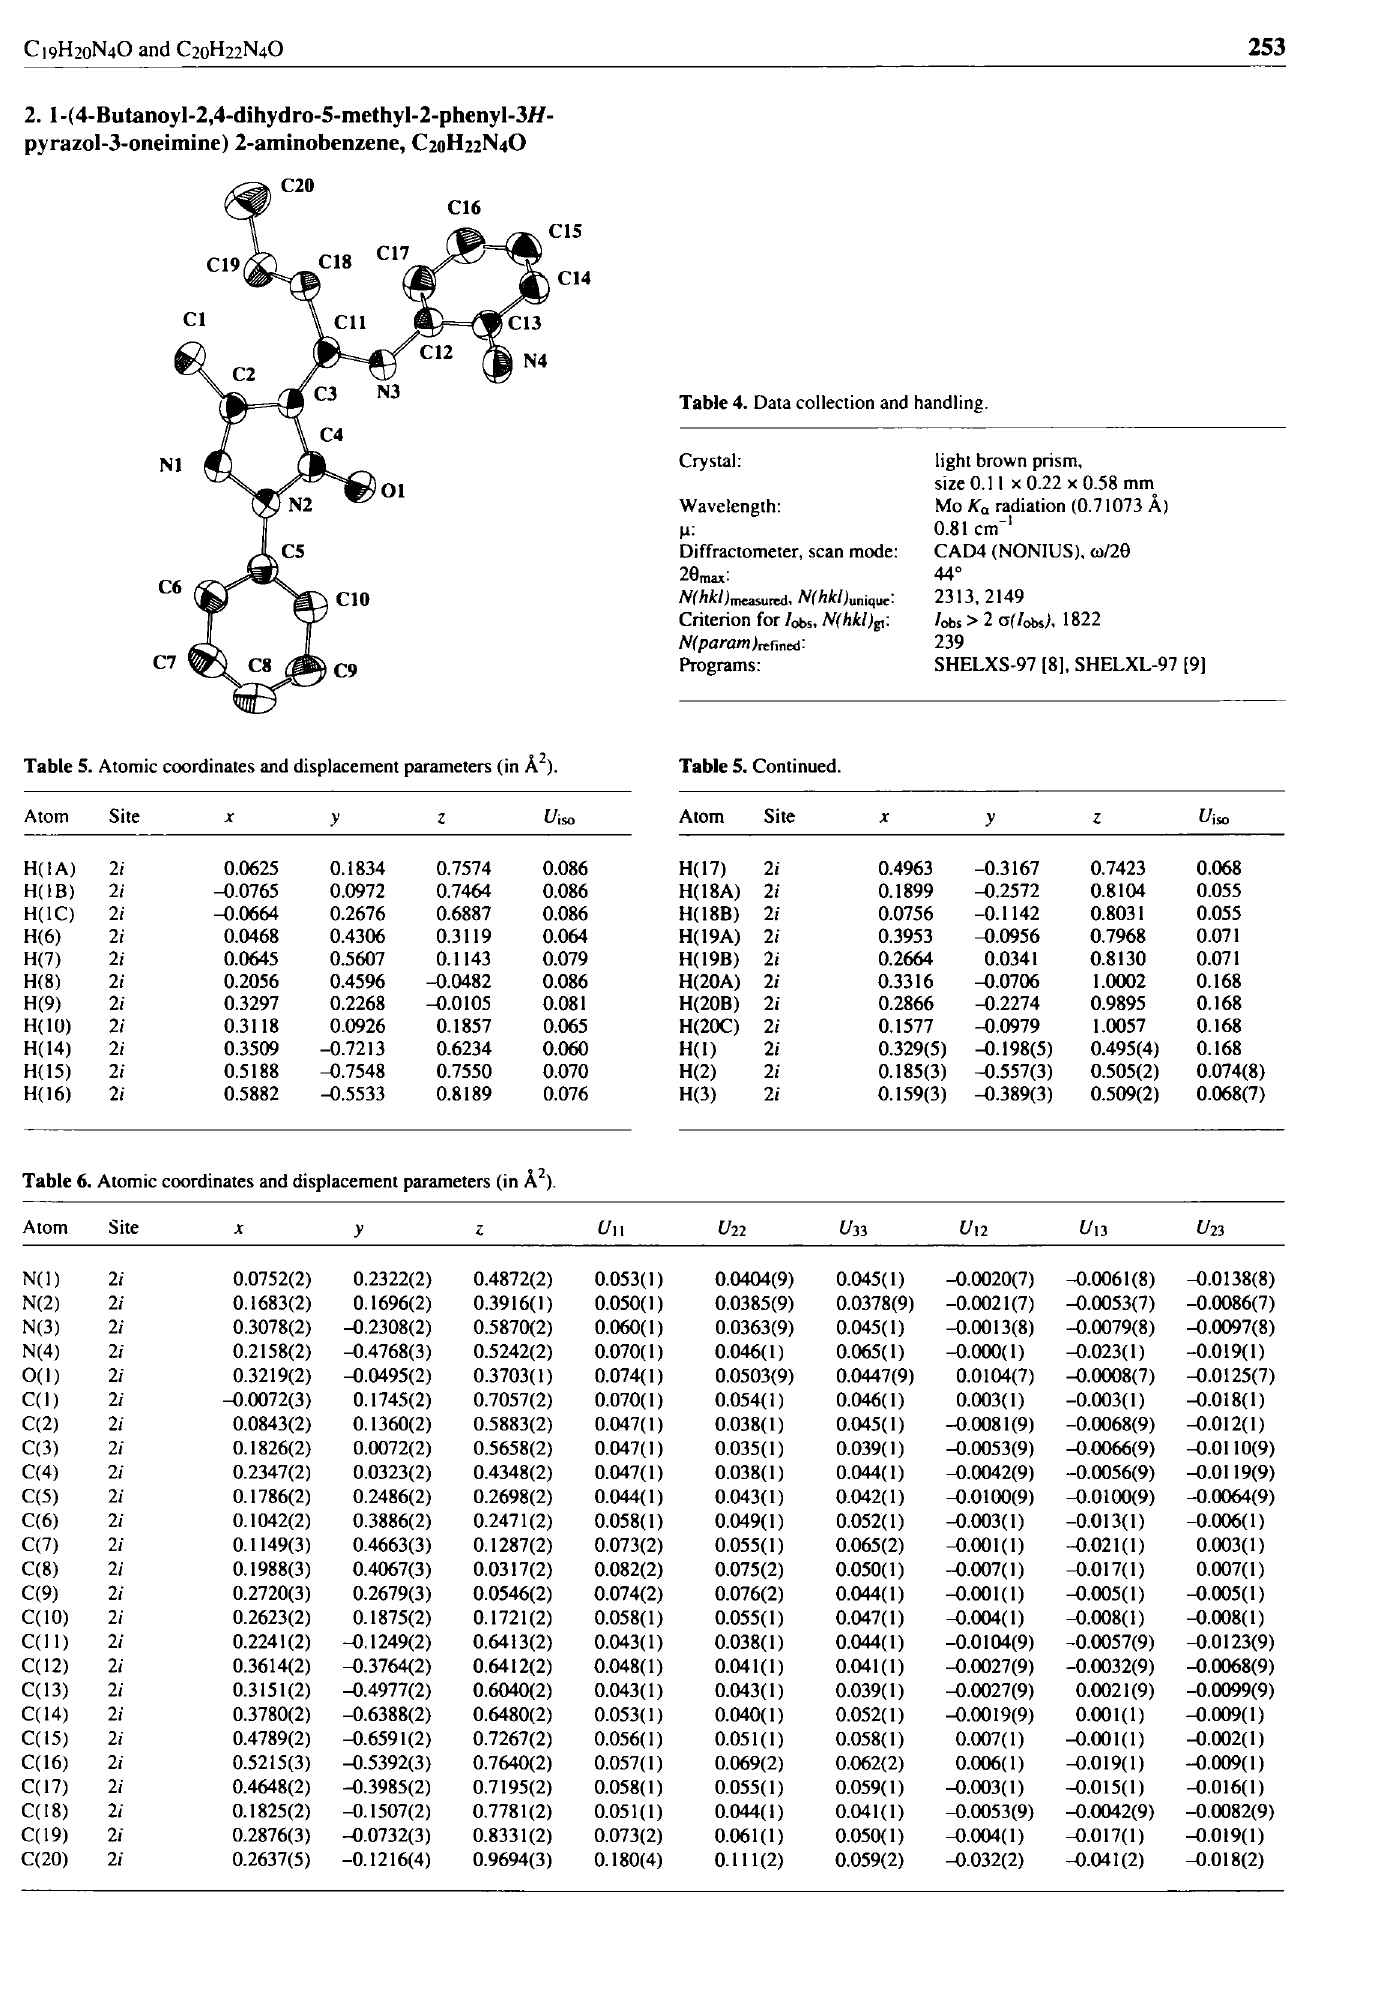
Table 4. Data collection and handling.